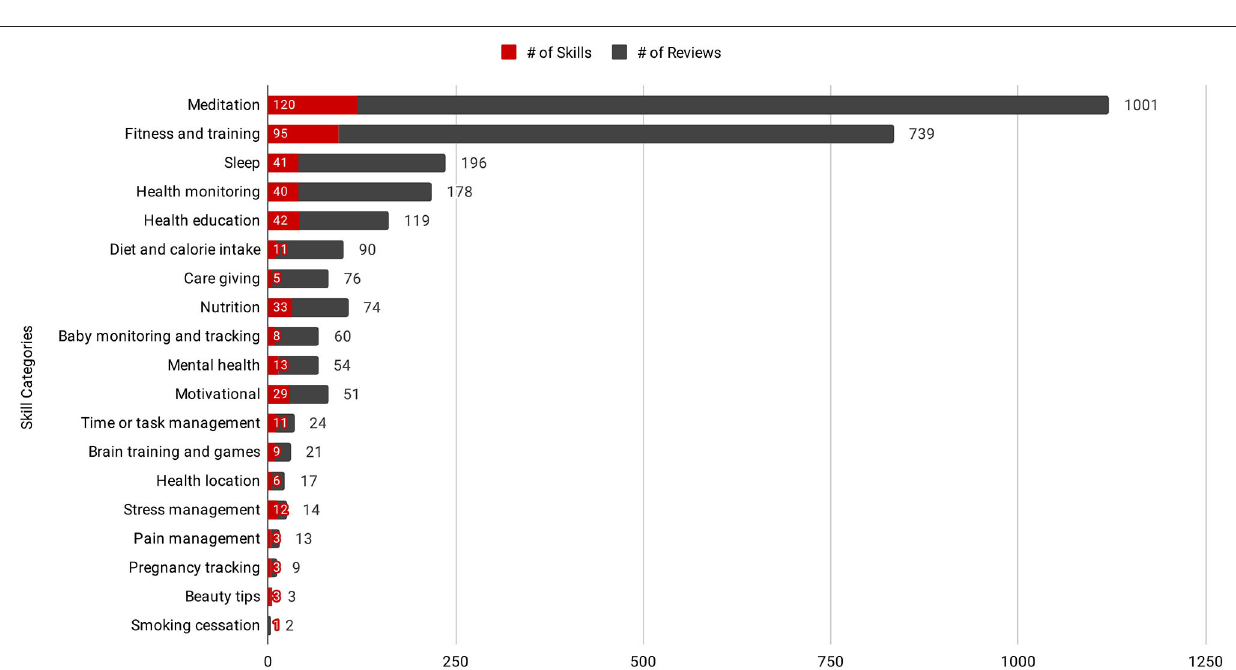
Frontiers in Digital Health |